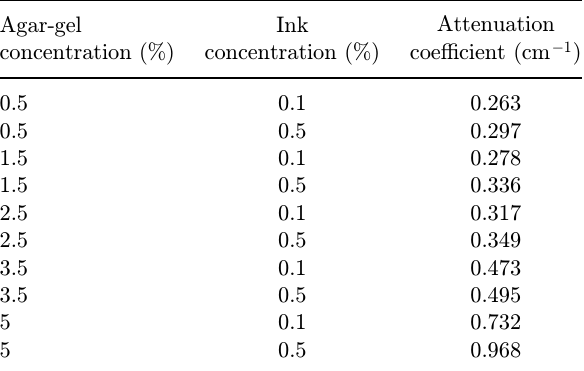
Table 2. Attenuation coe±cient (cm (cid:2) 1 ) according to the concentrations of agar-gel and